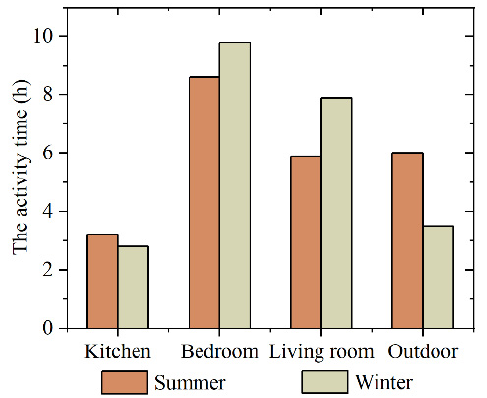
Figure 2. Daily use time in different rooms.